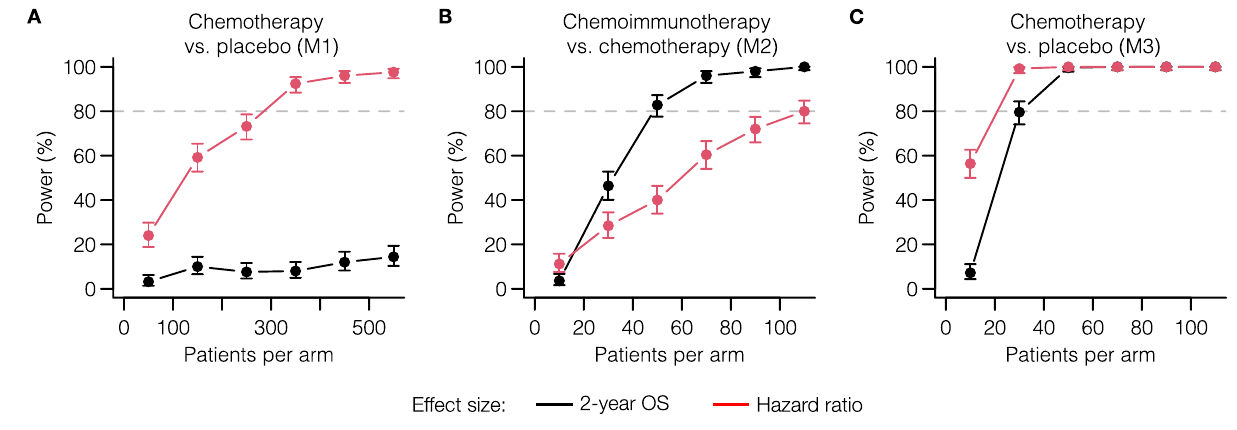
Fig. 5 | Immunotherapy-speci fi c survival curve shapes critically determine a trial ’ s power to detect different treatment effects. We analyzed the power of in silico trials to detect a difference in 2-year OS (black lines) or a hazard rationot equal to1 (red lines) for ( A ) chemotherapy vs. placebo (transient effect, M1); ( B ) chemoimmunotherapy vs. chemotherapy (M2); and ( C ) chemotherapy vs. placebo (long-term effect; M3). Choosing an inappropriate effect size for the response